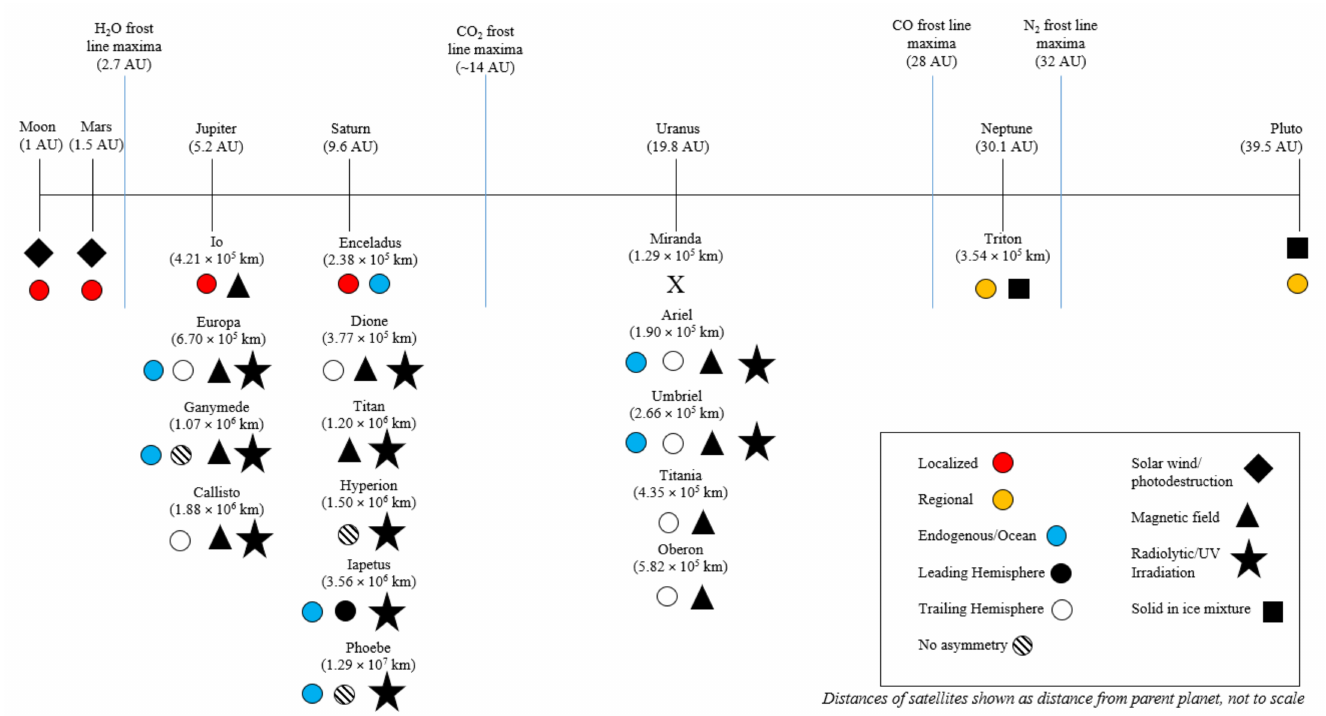
Figure 3. Map of the Solar System (in this review) regarding presence of CO 2 or CO on the surface (or subsurface), and possible environmental interactions at each satellite, such as magnetic fields or irradiation. Note that CO 2 is usually found on both trailing and leading hemispheres of these icy satellites, we mark the strongest presence of CO 2